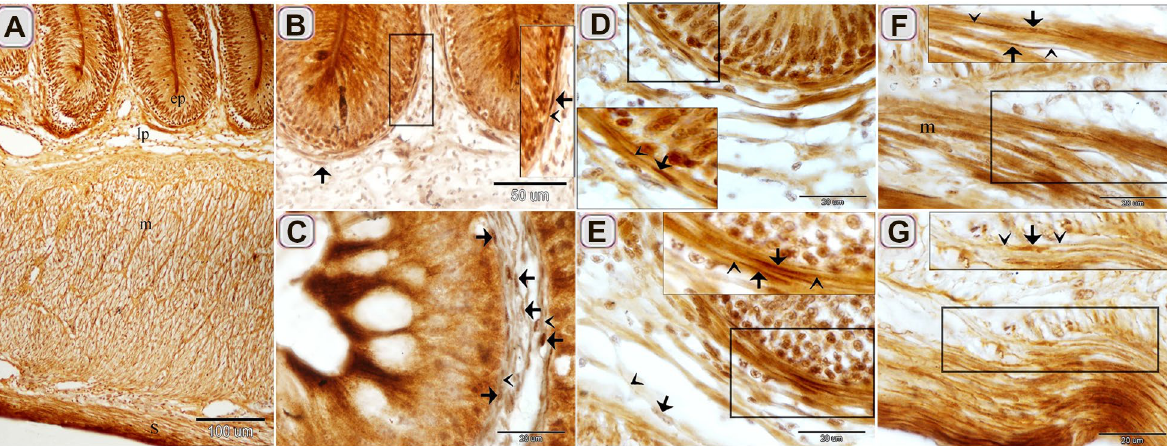
Figure 2. Identification of Telocytes in the intestinal bulb of Grass carp using Marsland silver stain. Paraffin sections of the intestinal blub stained by Marsland silver stain. ( A ) General histological picture of the intestinal bulb. Note epithlium (ep), lamina propria (lp), muscular layer (m), and serosa (s). ( B , C , E ) The cell body of TCs (arrows) formed a subepithelial sheath. Telopodes (arrowheads). ( D ) The cell body of the subepithelial TC (arrow). Telopodes (arrowheads). ( F , G ) The cell body of the intramuscular TC (arrow). Note muscle (m). Telopodes (arrowheads).